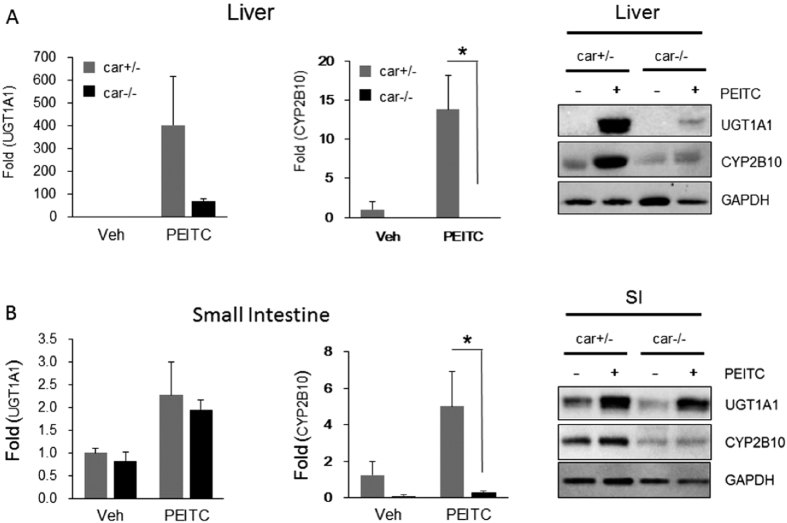
Induction by PEITC in adult hUGT1/Car−/− mice.Adult (8 week) hUGT1/Car−/− and hUGT1/Car+/− mice were treated by p.o administration with 200 mg/kg/day for four days. After treatment, RNA and total cell extracts were prepared. (A) From liver tissue, UGT1A1 and Cyp2b10 gene expression was analyzed by real time PCR and expressed as Fold induction. From the same tissues, total cell extracts were combined and used for Western blot analysis using anti-human UGT1A1 and anti-mouse CYP2B10 antibodies. The bands have been cropped from the full-length blots but not enhanced in anyway (S7). (B) From small intestine, a similar series of experiments were performed. Values are the means of ±SD (n > 3). Statistically significant differences between vehicle (Veh) and PEITC are indicated by asterisks (Student t test: *P < 0.05).